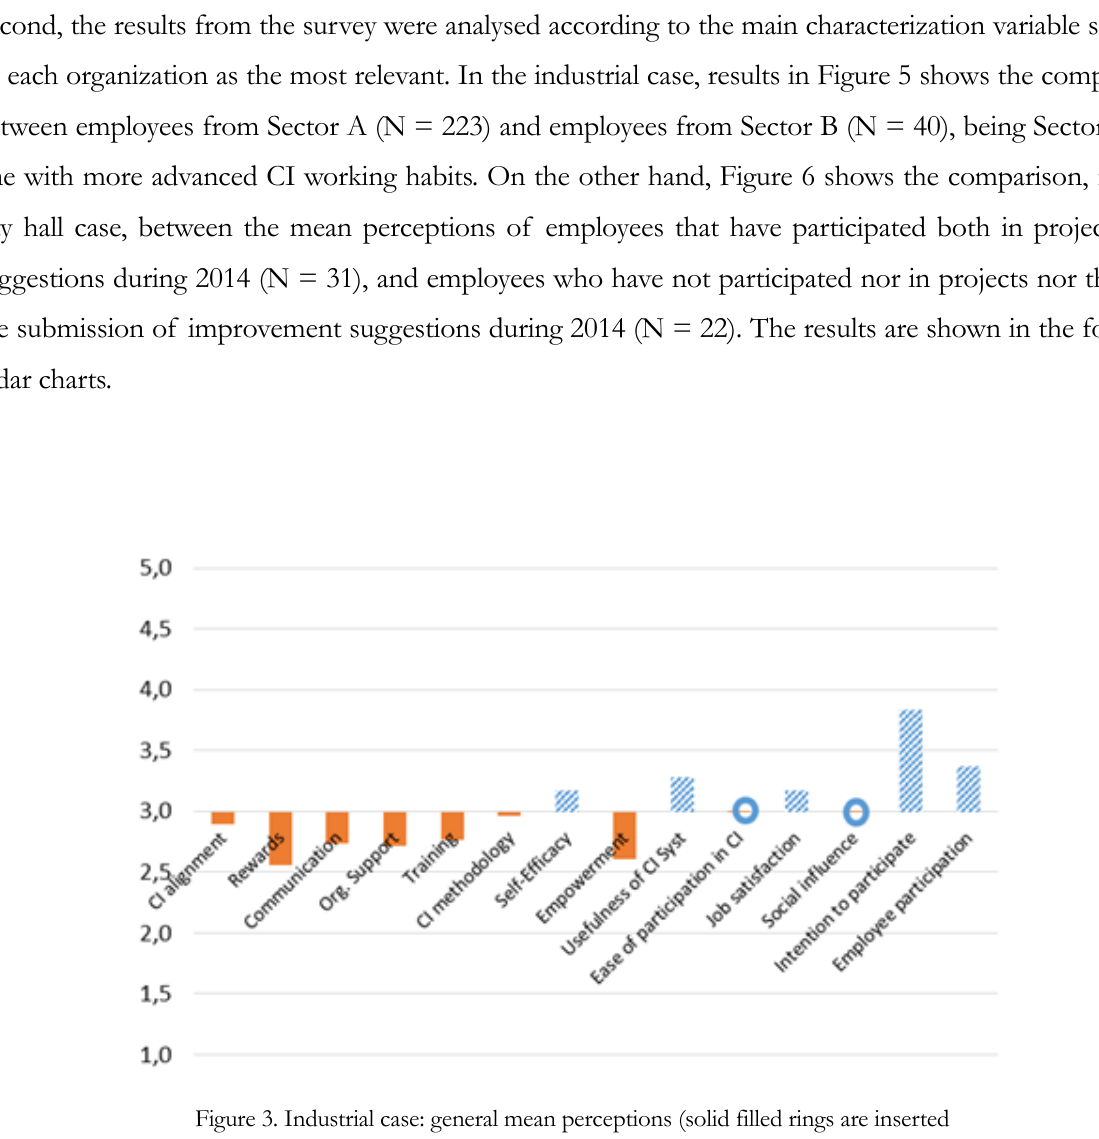
Figure 3. Industrial case: general mean perceptions (solid filled rings are inserted when the score of the factor is exactly 3 for better visualization)